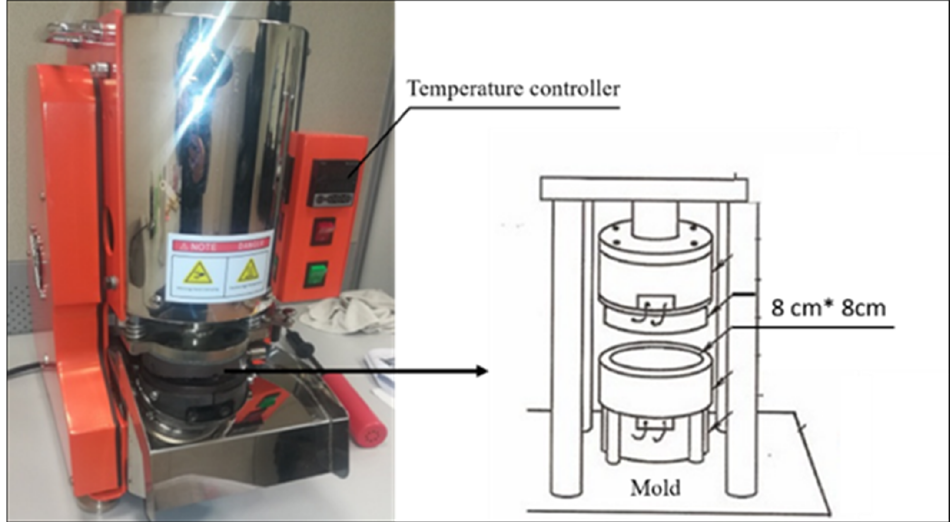
Figure 3. Moisture analyzer used to control the moisture level of the raw material.